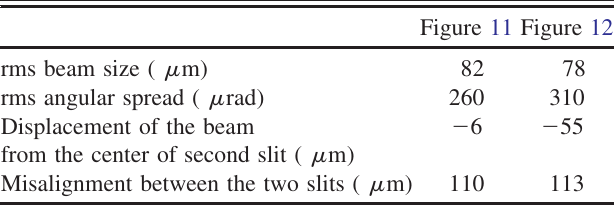
NONINTERCEPTING ELECTRON BEAM SIZE MONITOR . . TABLE I. Parameters obtained by fitting the theoretical model to the measured ODRI angular distribution for the two cases shown in Figs. 11 and 12.